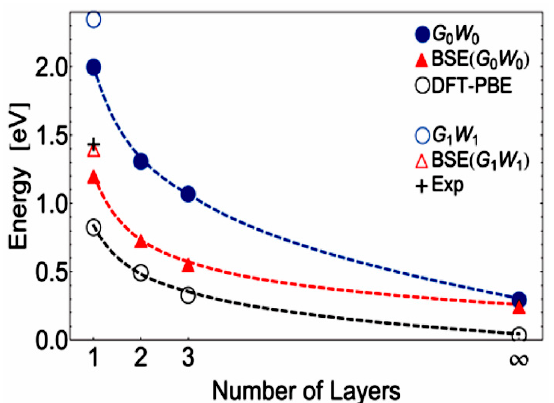
Figure 14. Band gap with increasing number of layers are calculated by various methods and fitting curves are presented with dashed lines: DFT—Density Functional Theory; PBE—Perdew–Burke–Ernzerhof functional; BSE—Bethe–Salpeter equation. The